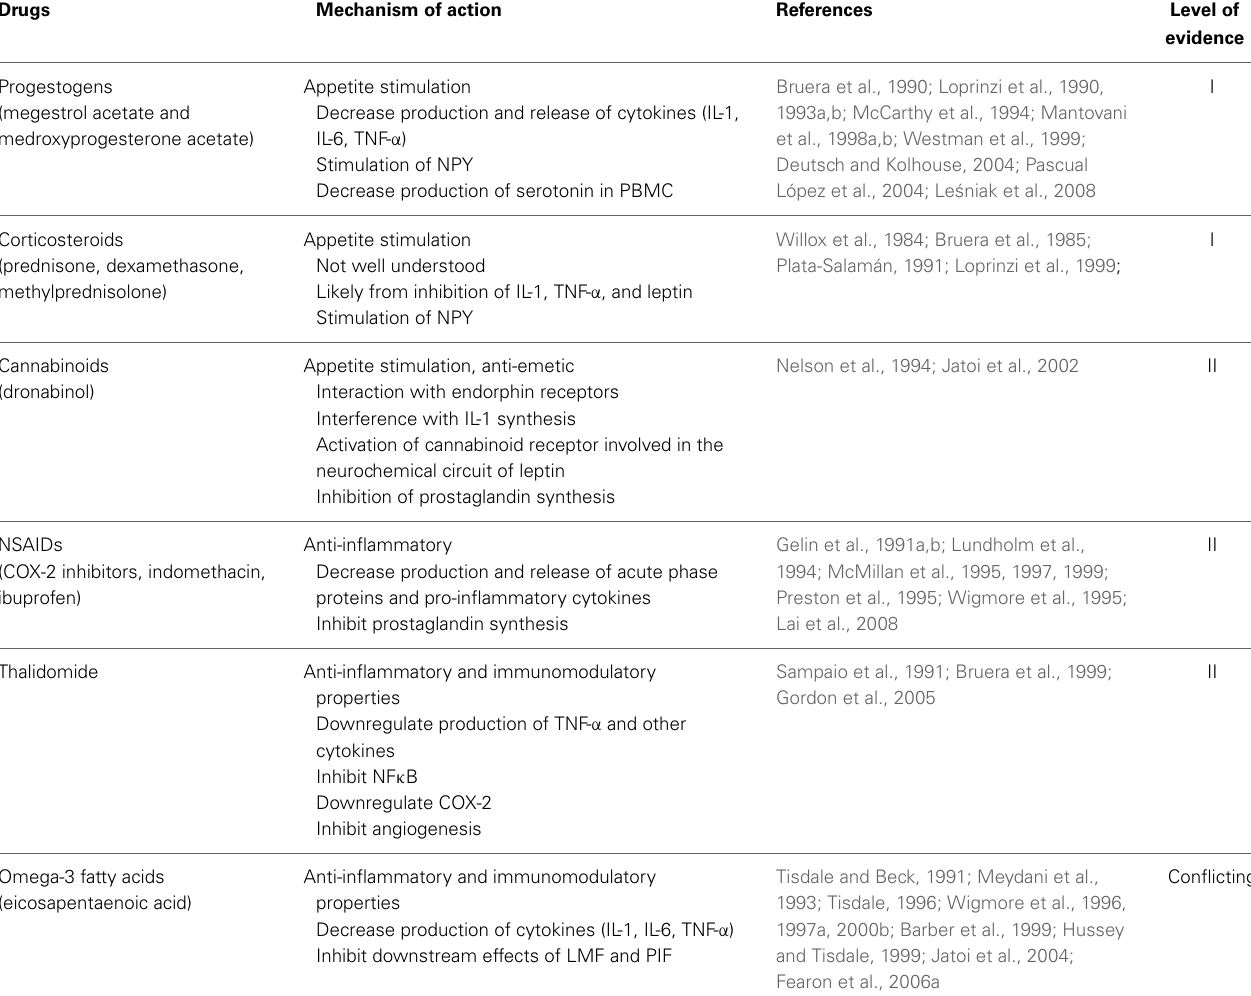
Table 3 | Pharmacological approach to pancreatic cancer